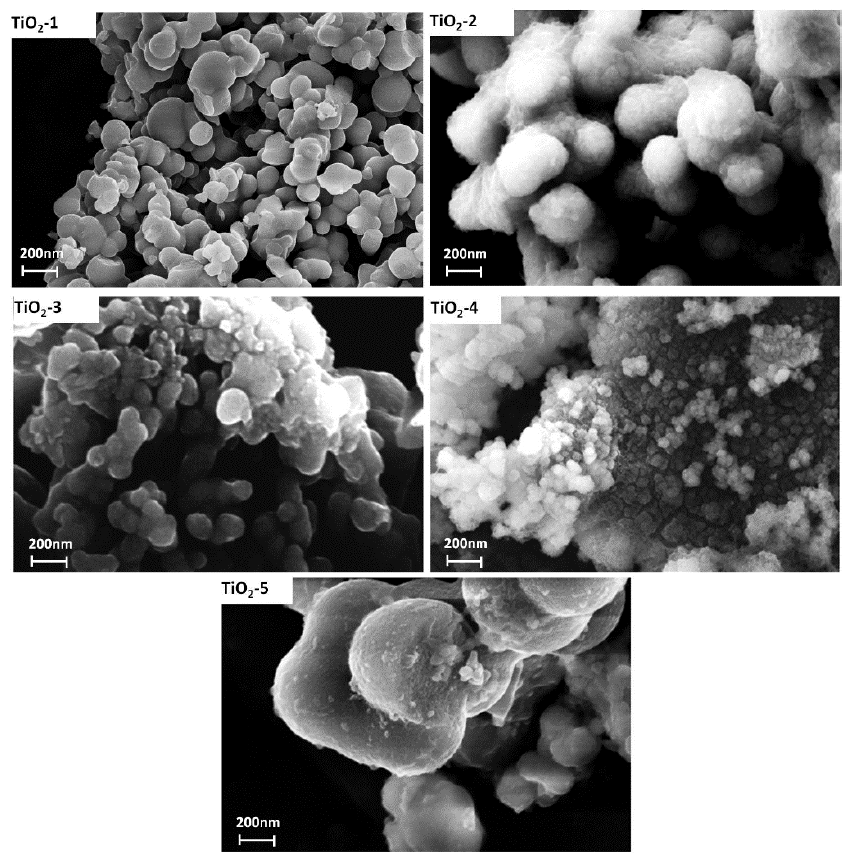
Figure 6. SEM micrograph of all samples.